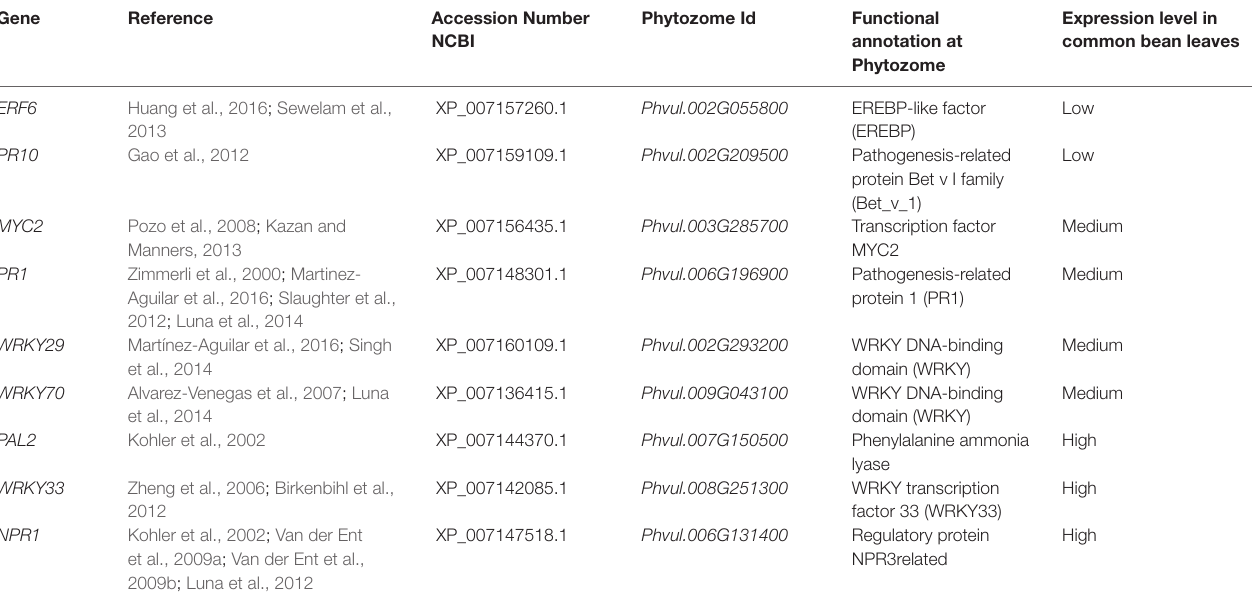
TABLE 2 | Genes selected for defense response and priming, and their experimental expression during ISR in Phaseolus vulgaris leaves.